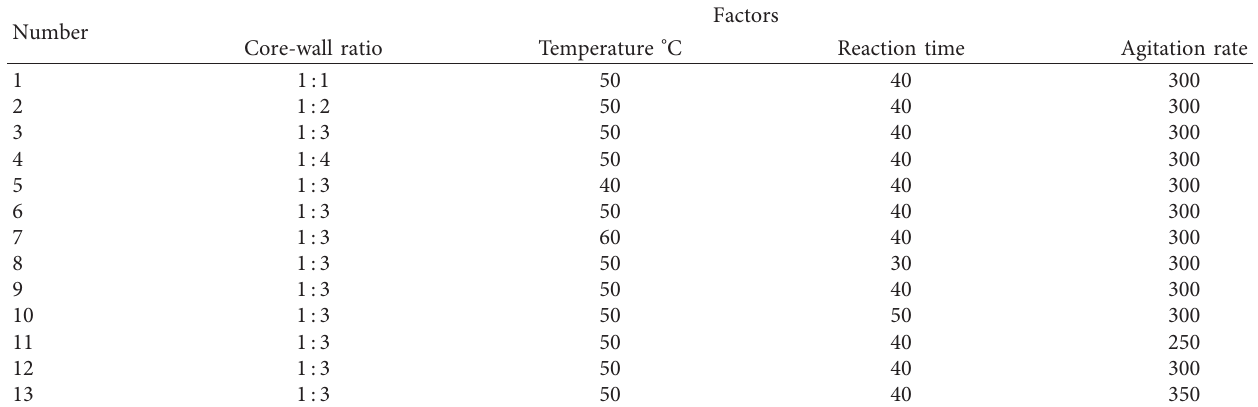
Table 3: Single-factor experiment